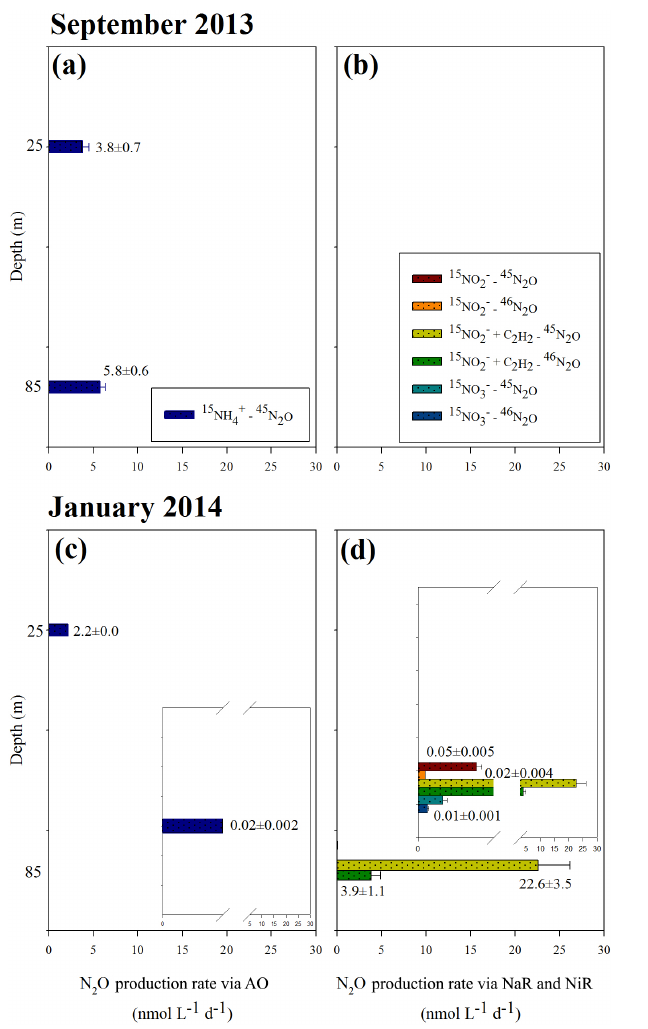
Figure 4. N 2 O production rates through AO (a, c) , and through NaR and NiR (b, d) measured in the oxycline (25m depth) and bottom layer (85m depth) at Sta. 18 over the continental shelf off central Chile during 12 September 2013 (a, b) and 28 January 2014 (c, d) . Conventions show the amended tracer ( 15 NH + 15 NO − ) , isotopic pairing in the gas produced, and inhibitor when 3 used (acetylene – “C 2 H 2 ”). Note that N 2 O produced in the incu- bations with C 2 H 2 represents gross production rates. Insets in (c) and (d) represent details of lower values at depth.